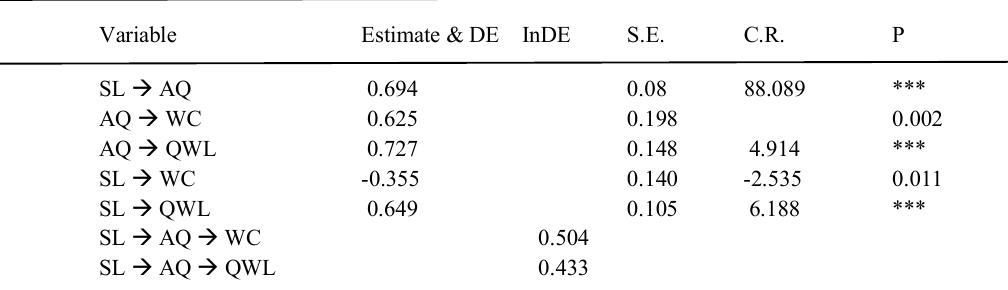
Tabel 2: Standardized Regression Weight, Direct-Indirect